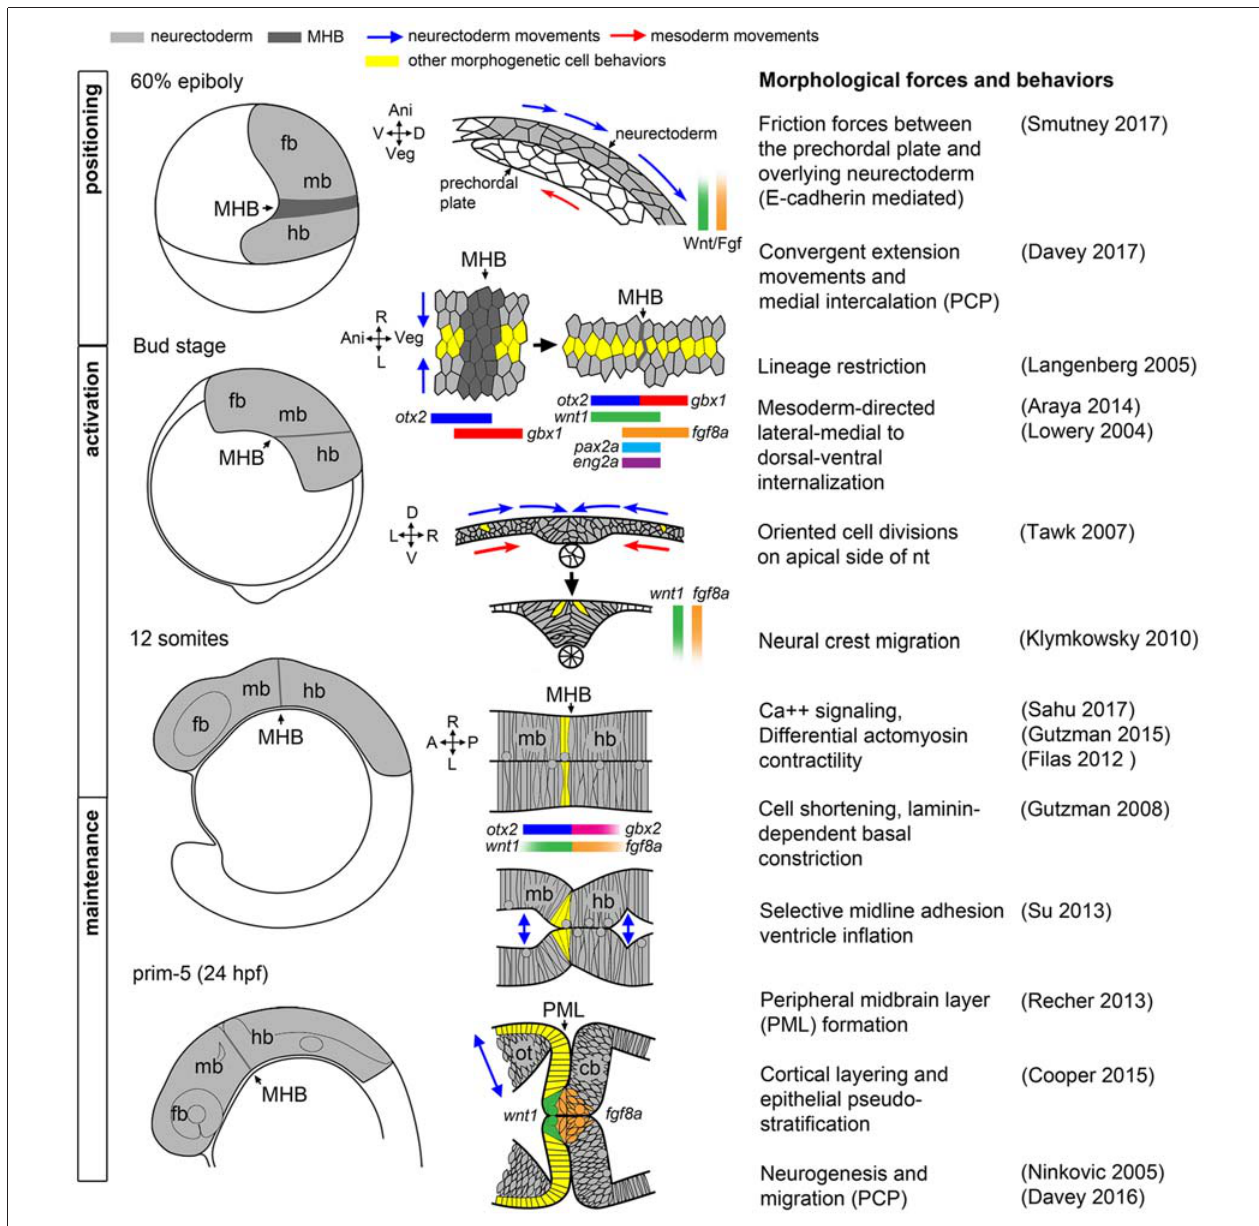
FIGURE 1 | Morphogenetic and molecular ontogeny of the midbrain hindbrain boundary (MHB) in zebrafish embryos. Left column: schematic diagrams of zebrafish embryos, lateral view, at stages indicated on left. Gray shading highlights the brain primordium. Middle column: diagrams of pertinent morphogenetic movements. Orientation is indicated on the left side of each diagram. Examples of each morphogenetic property can be found in the corresponding references in the right column. fb, forebrain; mb, midbrain; hb,